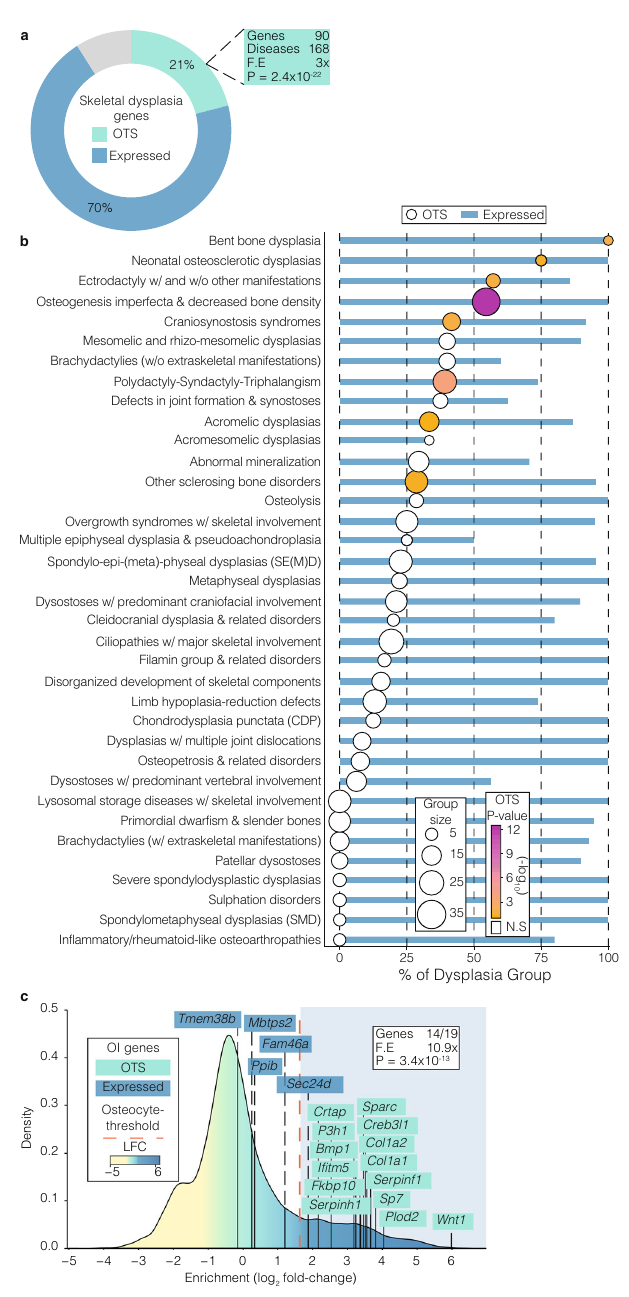
Fig. 6 The osteocyte transcriptome signature is enriched with genes associated with rare genetic skeletal disorders. a Proportion of genes (%) known to cause genetic skeletal disorders 21 that have human orthologs either actively expressed in osteocytes (blue), present in the osteocyte transcriptome signature (OTS) (green) or not active in osteocytes (grey). P -value and fold-enrichment (FE) of osteocyte transcriptome signature genes among disease-causing genes are calculated under the hypergeometric distribution. b Proportion of genes (%) in individual skeletal disease groups that have orthologs actively expressed in osteocytes (blue bars) or present in the osteocyte transcriptome signature (circles). Group size = number of genes in each disease group. Groups with genes signi fi cantly enriched in the osteocyte transcriptome signature are coloured according to P -value (Bonferroni adjusted), calculated by hypergeometric test. Only groups with ≥ 3 genes are represented. N.S.